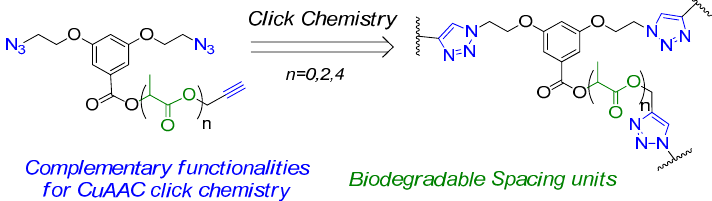
Int. J. Mol. Sci. 2023 , 24 , x FOR PEER REVIEW 3 of 14 Figure 1. Schematic representation of the key strategy developed in this work. Figure 1. Schematic representation of the key strategy developed in this work.